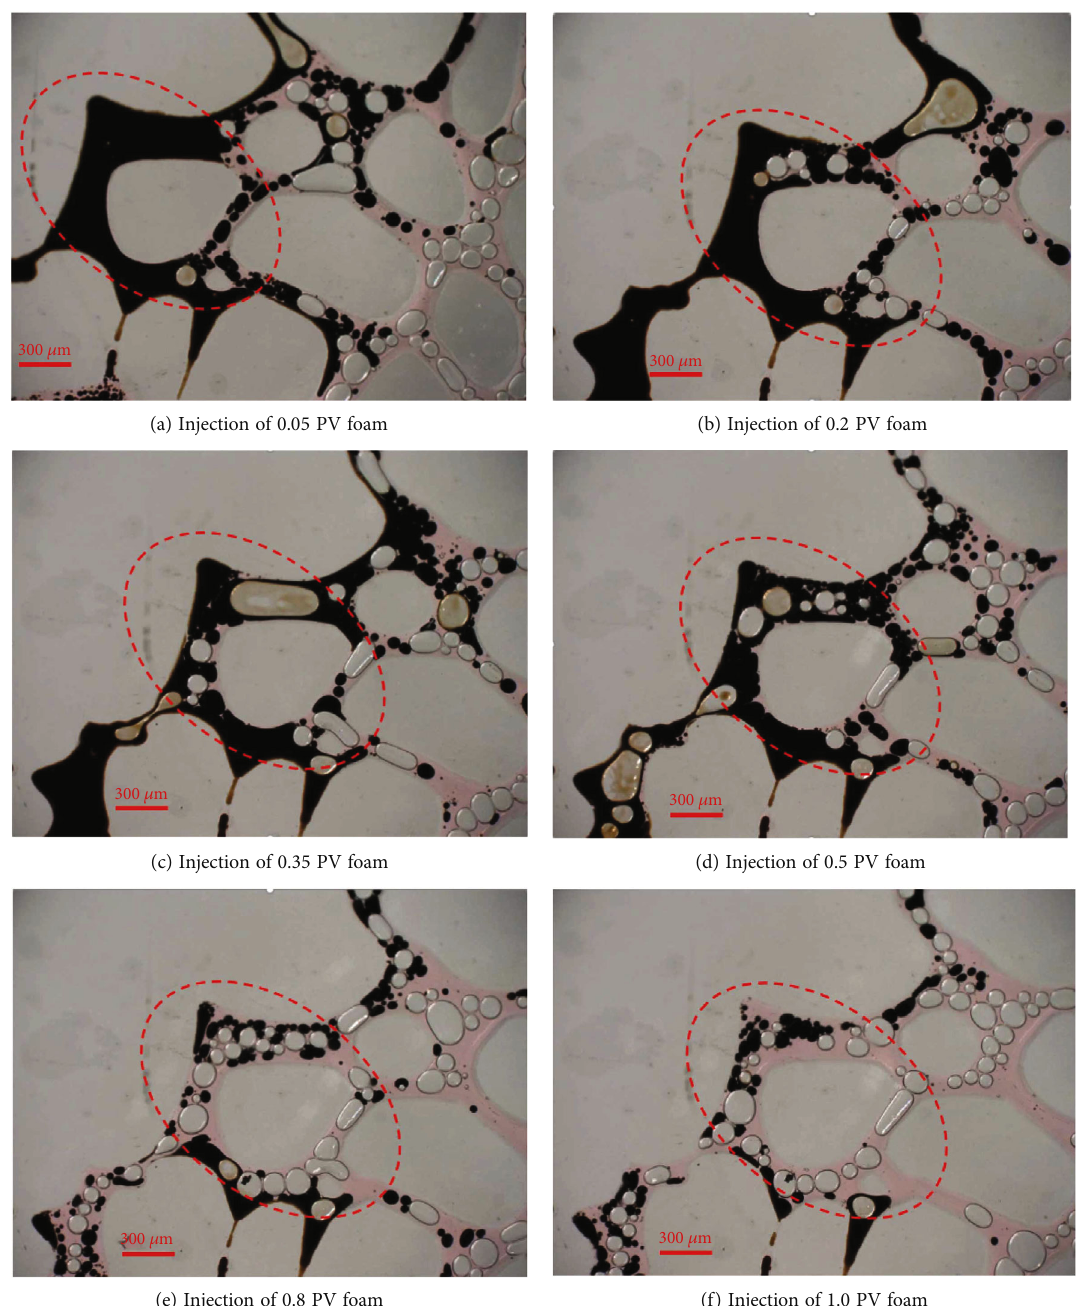
Figure 7: Microscopic fl ow characteristics of foam fl ooding oil